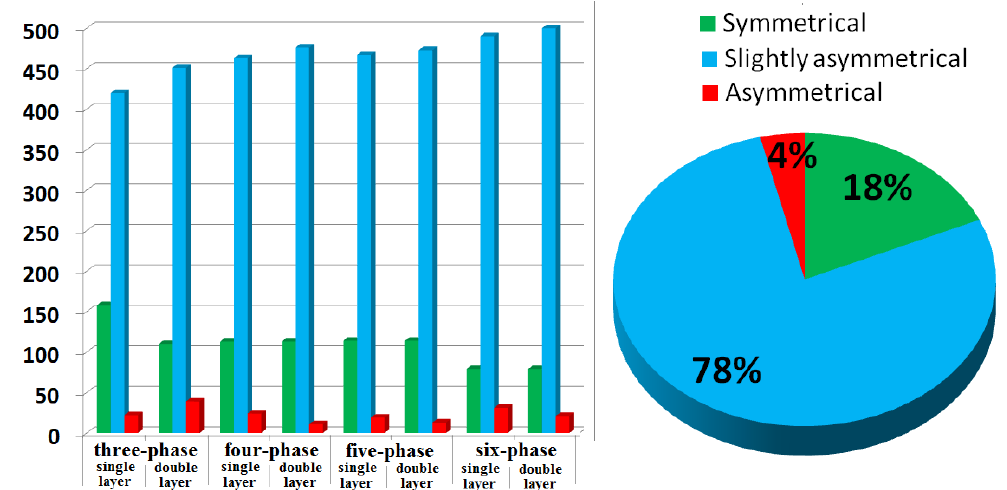
Figure 1. Graphical summary for the symmetrical, slightly asymmetrical and asymmetrical winding